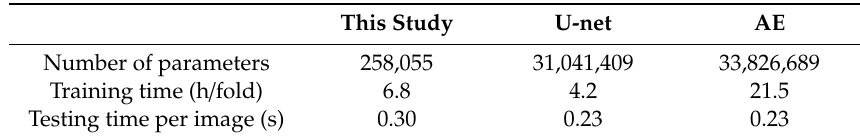
Table 4. Number of parameters, training time, and testing time used in the proposed system compared with other CNN-based methods. This